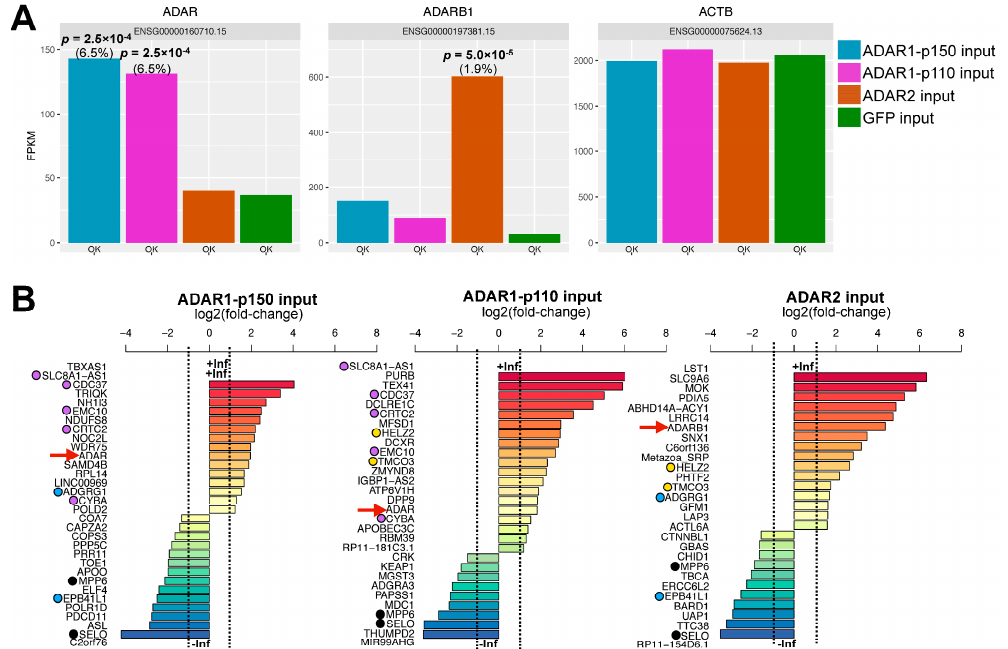
Figure 2. Differentially expressed genes upon specific ADAR isoform overexpression. ( A ) Coverage of the ADAR ( ADAR1 ), ADARB1 ( ADAR2 ), and ACTB genes expressed in reads per kilobase per million reads (RPKM). ADAR codes for both the ADAR1-p150 and ADAR1-p110 isoforms, ADARB1 codes for ADAR2 isoform, and ACTB codes for Actin B. The p -value relative to GFP input is indicated in bold and the corresponding false discovery rate (FDR) in brackets; ( B ) Fold-change relative to GFP input for significant DEGs (FDR ≤ 6.5%; p ≤ 2.5 × 10 − 4 ) expressed on a logarithmic scale. The ADAR and ADARB1 controls are highlighted with a red arrow. Black filled circles: DEGs common to all three isoforms; purple filled circles: common to ADAR1-p150 and ADAR1-p110; blue filled circles: common to ADAR1-p150 and ADAR2; yellow filled circles: common to ADAR1-p110 and ADAR2.